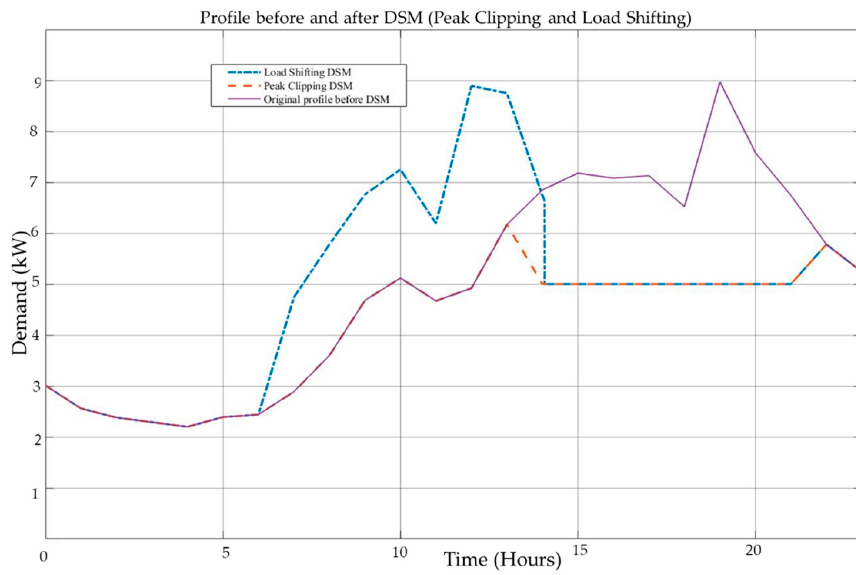
Figure 19. Load profile before and after DSM (load-shifting), 24 h system, Bunjako Island.